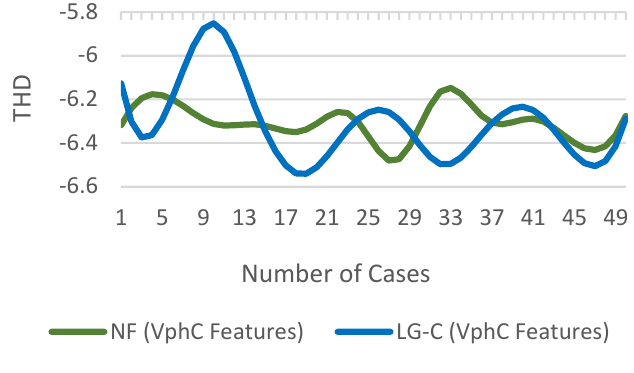
Figure 16. THD of Vph C for NF and fault cases.